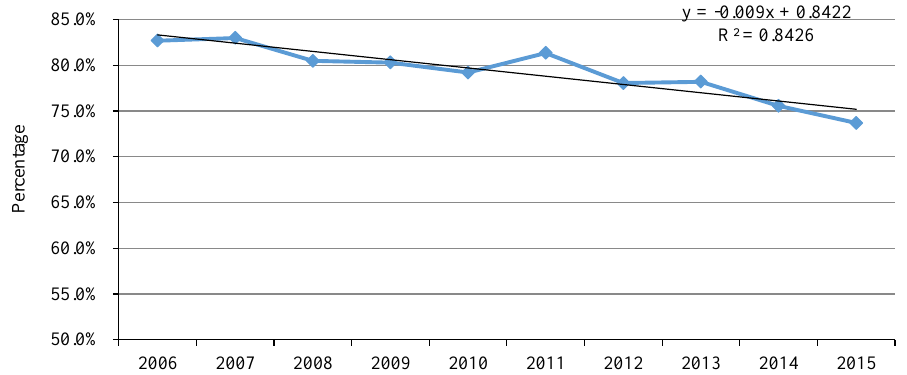
Figure 1. The share of thermal electricity generation in the total electricity in China. * Data source: the website of National Bureau of Statistics of the People’s Republic of China.